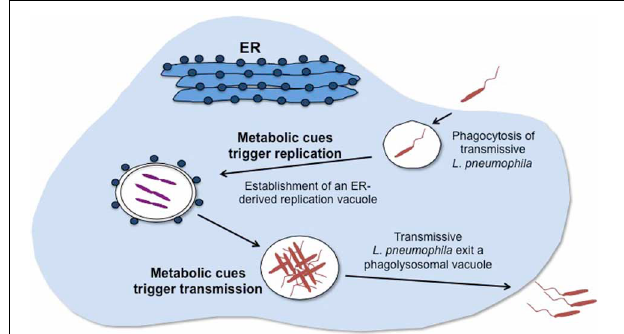
FIGURE 1 | Metabolic cues govern L. pneumophila cellular differentiation. The infectious, motile, transmissive form of L. pneumophila enters its host by phagocytosis. Nutrient abundance is signaled by metabolites, such as amino acids, which trigger differentiation of L. pneumophila to the replicative form that then multiplies in an ER-derived vacuolar compartment. Nutritional starvation, signaled by accumulation of particular metabolites, activates the stringent response and a regulatory cascade that coordinates differentiation of L. pneumophila to the transmissive form, which seeks a new site favorable for